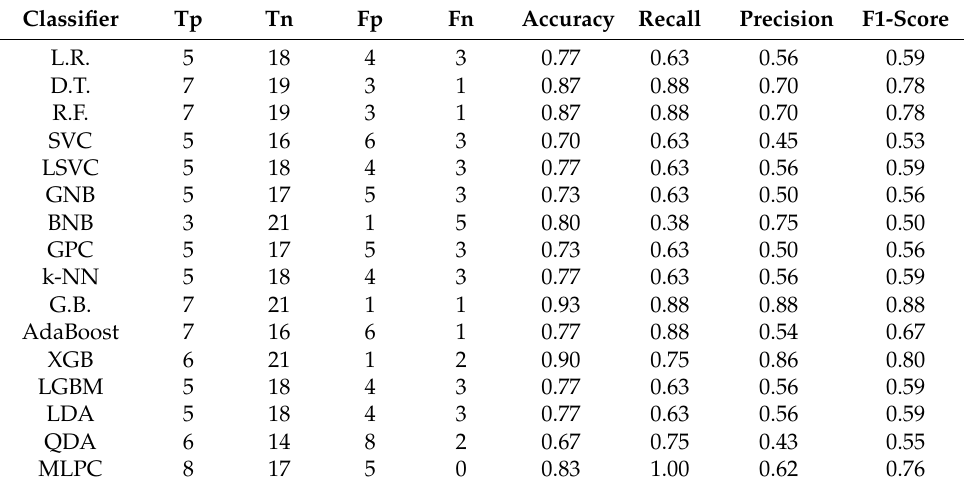
Table 1. Results of applying trained models of machine learning algorithms to the test